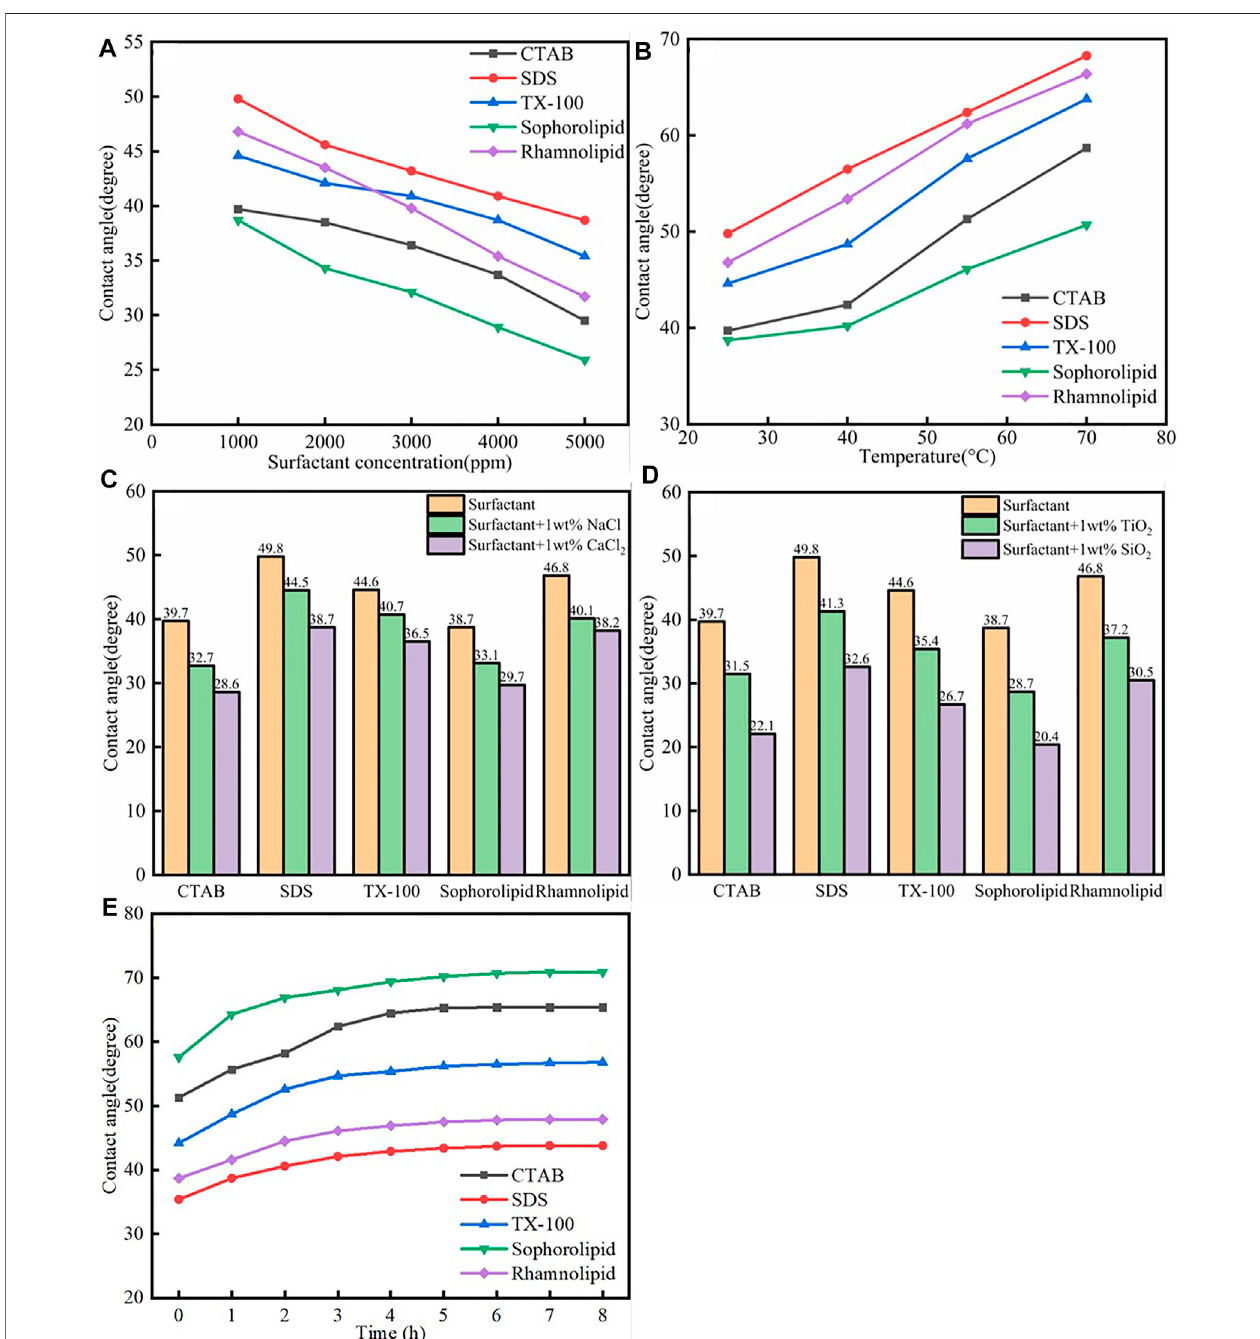
FIGURE 11 | (A) Surfactants species; (B) Temperature; (C) Salinity; (D) Nanoparticles- assisted effect on the calcite surface wettability — static contact angle measurement. (E) The different surfactants assisted calcite surface wettability alteration-dynamic contact angle measurement.